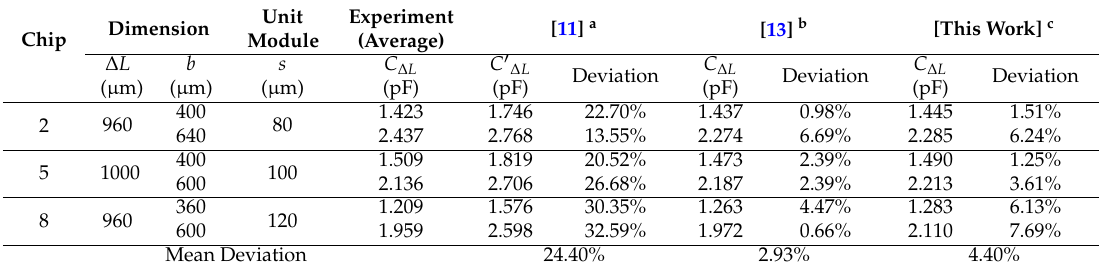
Table 8. Comparisons of capacitance between experiment and formulae ( µ = 0.5).